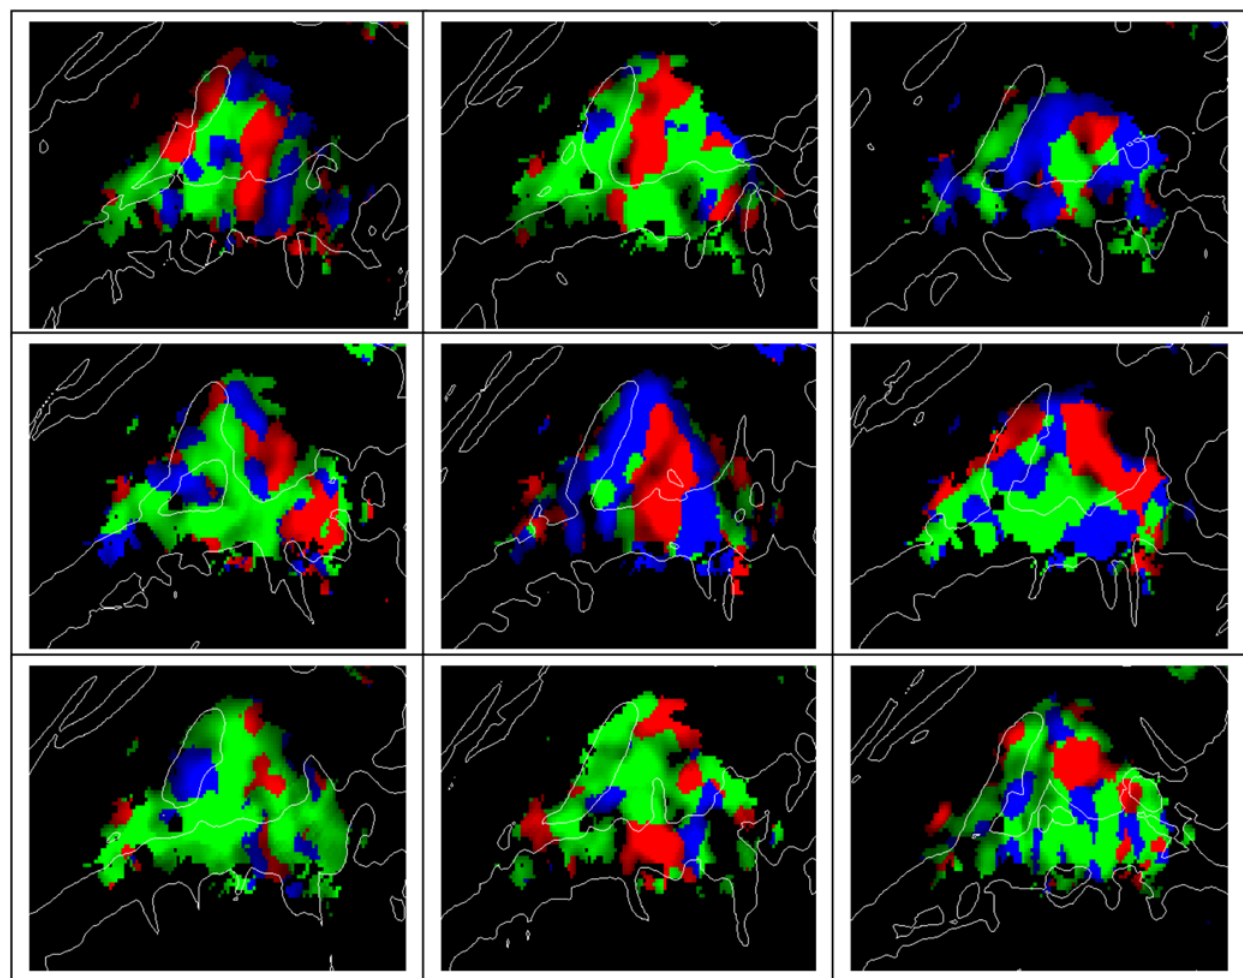
Figure 6. Tonotopic organization of auditory cortex in each of the nine individual subjects. Plots show regions with significant auditory activations coded by the frequency that produced maximal activation at that point. Red=3600 Hz, Green=900 Hz, Blue=225 Hz. In each subject, activations were averaged over hemispheres, over continuous and sparse sampling, attention conditions, sound spatial position, and sound intensities and projected on the individual’s left hemisphere cortical surface anatomy. Top: subjects 1–3, center: subjects 4–6, bottom: subjects 7–9. z- score threshold=3.0.